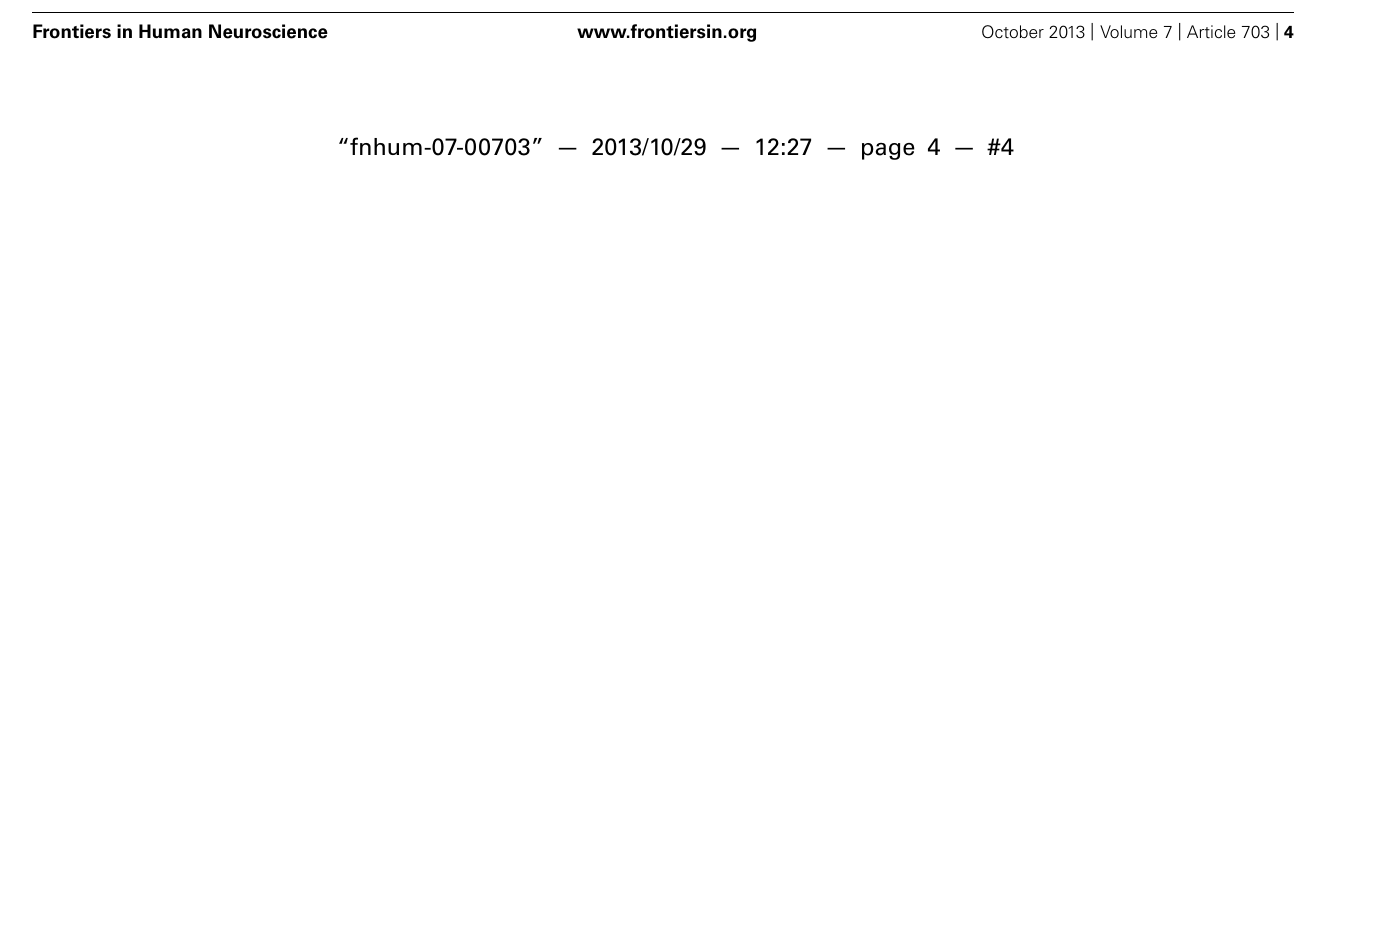
one right PFC patients had larger lesions including the superior anterior quadrant of the left and right temporal lobe,